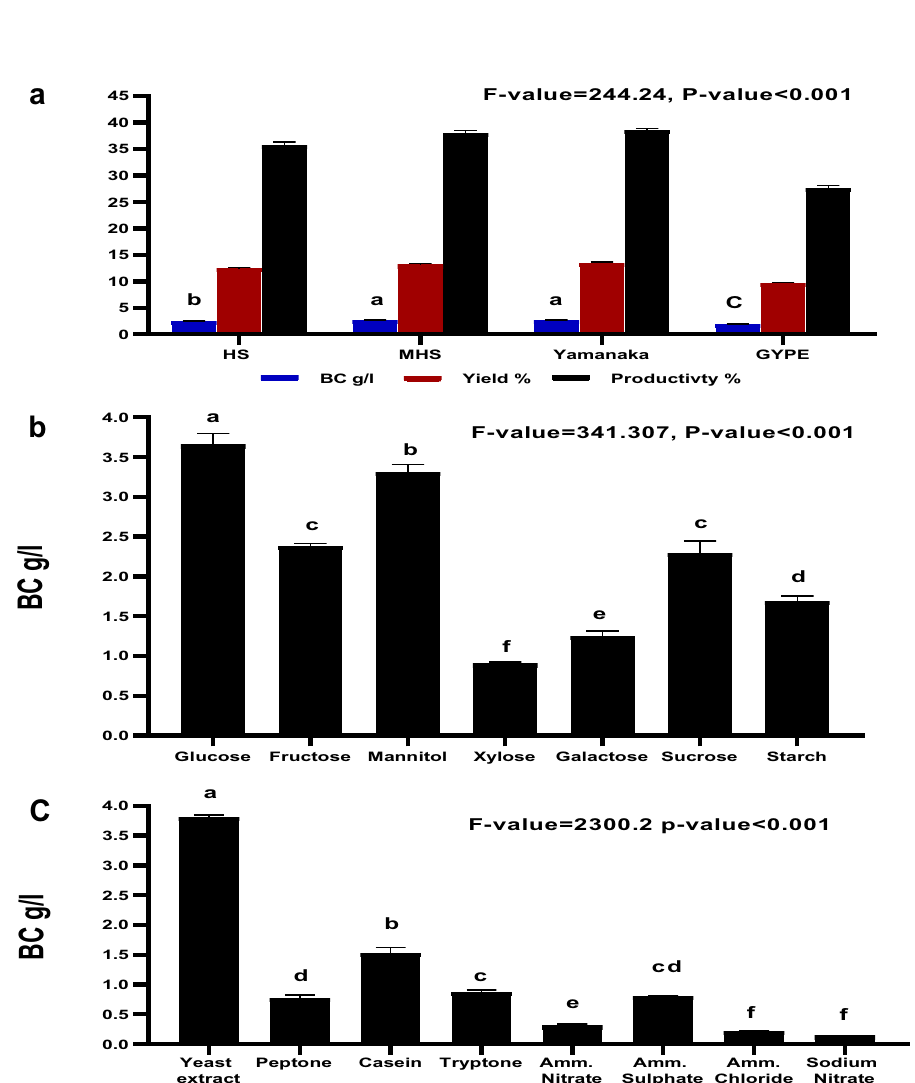
Figure 3. Effect of different media ( a ), carbon sources ( b ) and nitrogen sources ( c ) on the BC production by L. plantarum AS.6. Different letters above histogram are significantly different according to least significant difference test at p <